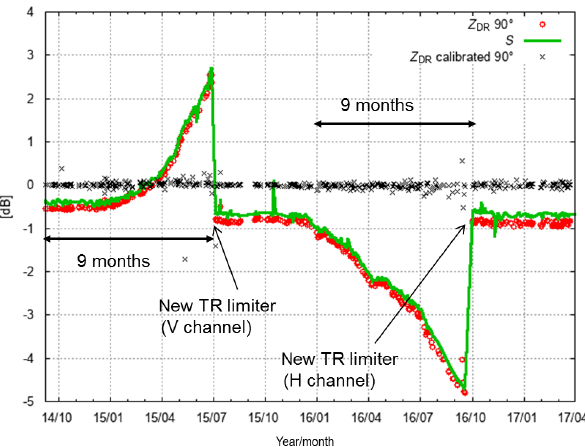
Figure 20. TR limiter failure at the Eisberg radar. This illustrates the benefits of using solar monitoring and birdbath scans to assess biases in the receive path. Here, the combination of solar monitor- ing (solar power S ) and birdbath analysis isolates the receive path as the source of the Z DR problem. In addition we show the result- ing calibrated Z DR , where the calibration offset is determined from birdbath data